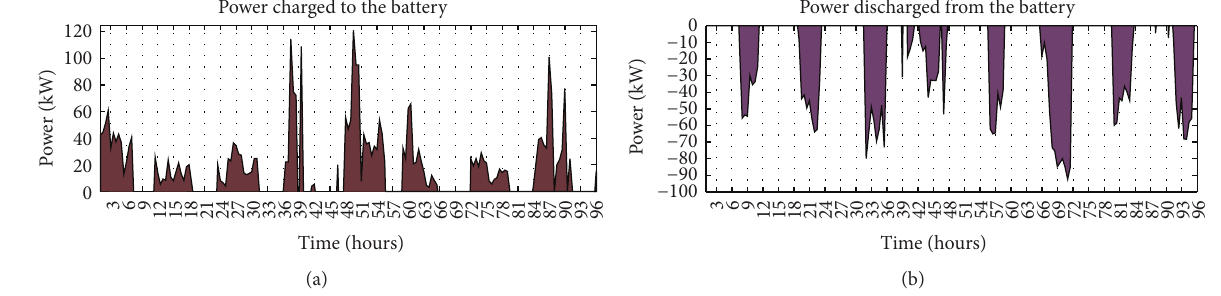
Figure 11: (a) Power charged to the battery. (b) Power discharged from the battery.